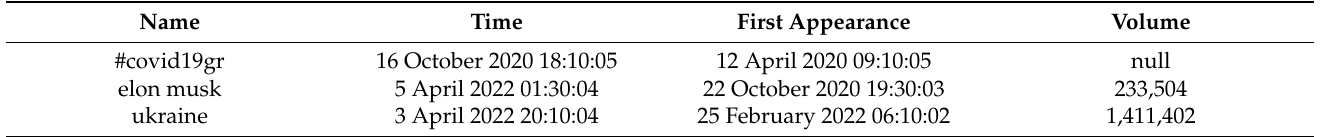
Table 1. Example of original Data for Trending Topics (place ID = Greece).